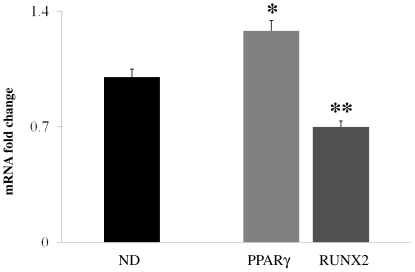
mRNA fold change.PPARγ2 and Runx2 in circulant MSCs-like from normal donors (NDs) and osteoporotic patients (OPs), * p<0.005 vs NDs and **p<0.001 vs NDs, respectively. The fold change was obtained by using three different housekeeping genes (GAPDH, β2 microglobulin, beta-actin).